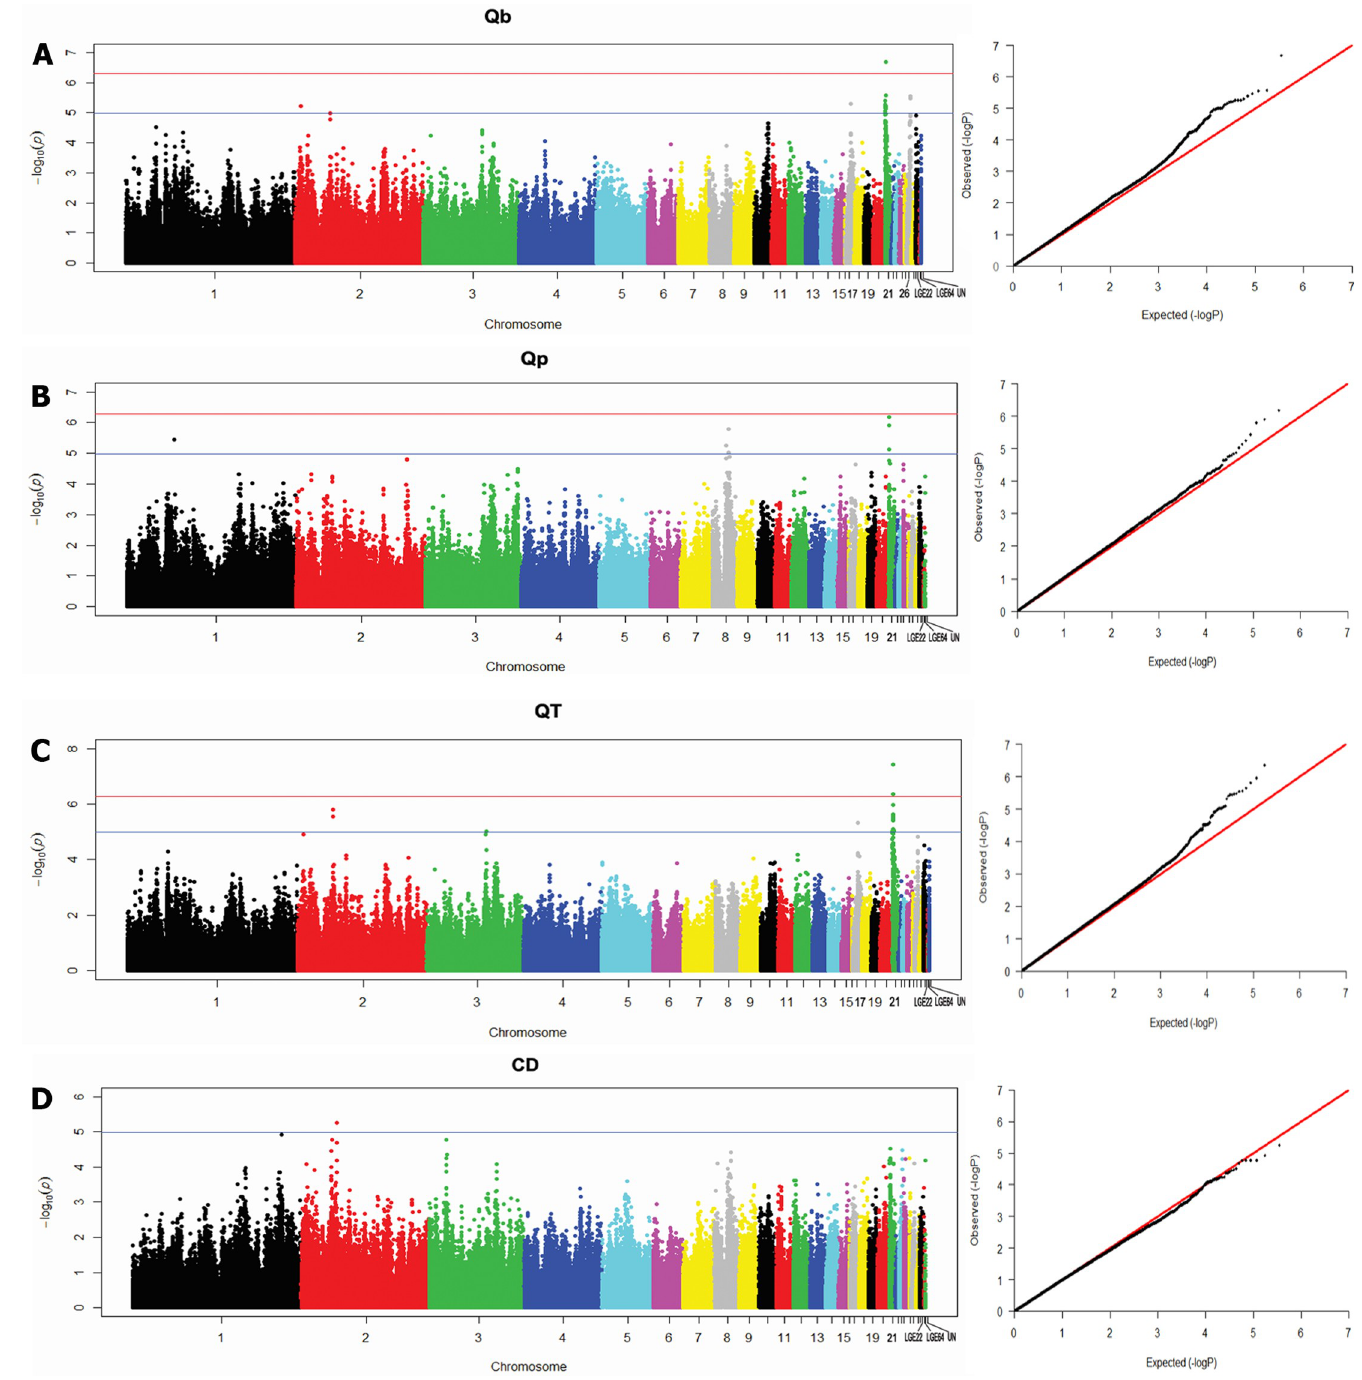
Fig 1. Manhattan plot (left) and quantile-quantile plot (right) of the observed P-values for QB (A), QP (B), QT (C) and CD (D) . In Manhattan plot, the red and gray horizontal lines indicate the genome-wise significance threshold [-log10 (5.135E-07)] and suggestive significance threshold [-log10 (1.027E-05)], respectively.